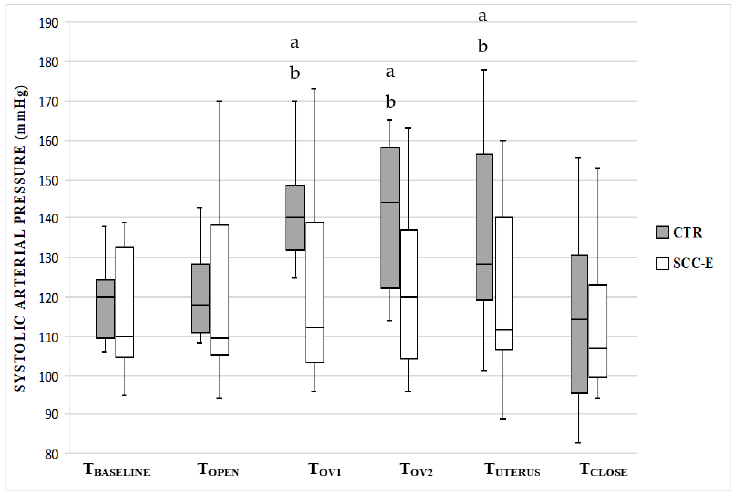
Figure 2. Systolic arterial pressure (SAP) in cats undergoing ovariohysterectomy with (SCC-E group) or without (CTR group) sacrococcygeal epidural ( n = 10 in each group). Times: T BASELINE , prior to skin incision; T OPEN , abdominal skin incision; T OV1 , from traction to removal of left ovary; T OV2 , from traction to removal of right ovary; T UTERUS , traction and ligation of the uterus; T CLOSE , during celiorraphy until the end of surgery. The horizontal line inside the boxes denotes the median value, while the upper and lower whisker bounds denote the maximum and minimum values. The boxes show the interquartile ranges. a Significant difference compared with T BASELINE ( p -values were 0.009 and 0.006 for T OV1 and T OV2 , respectively. b Significant difference compared with the SCC-E group ( p- values were 0.040 and 0.037 for T OV1 and T OV2 , respectively.